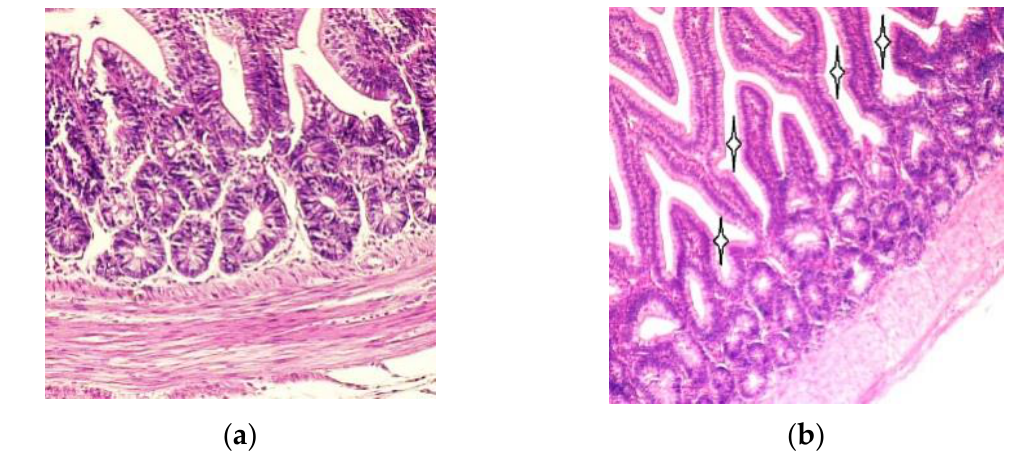
Figure 1. ( a ) Duodenal villi and crypts in normal seven-day-old chicken mucosa, Hematoxylin–eosin 200 × ; ( b ) Villi and cryptae duodenales in toxicated seven-day-old chicken mucous layer. Note the narrow duodenal villi and enlarged intervillar spaces (asterisks). Hematoxylin–eosin, 100 × .